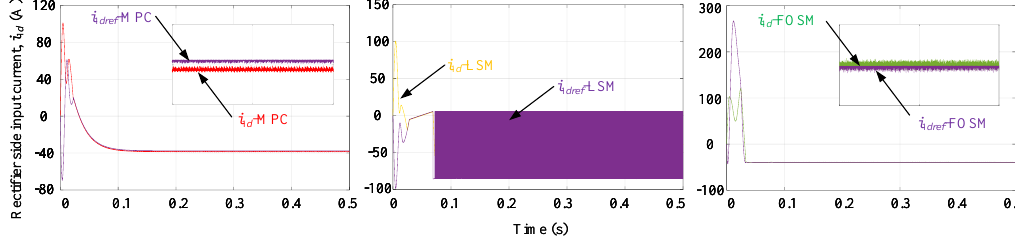
Figure 6. Therectifier side d -axis current responses under the MPC, the LSM and the FOSM.